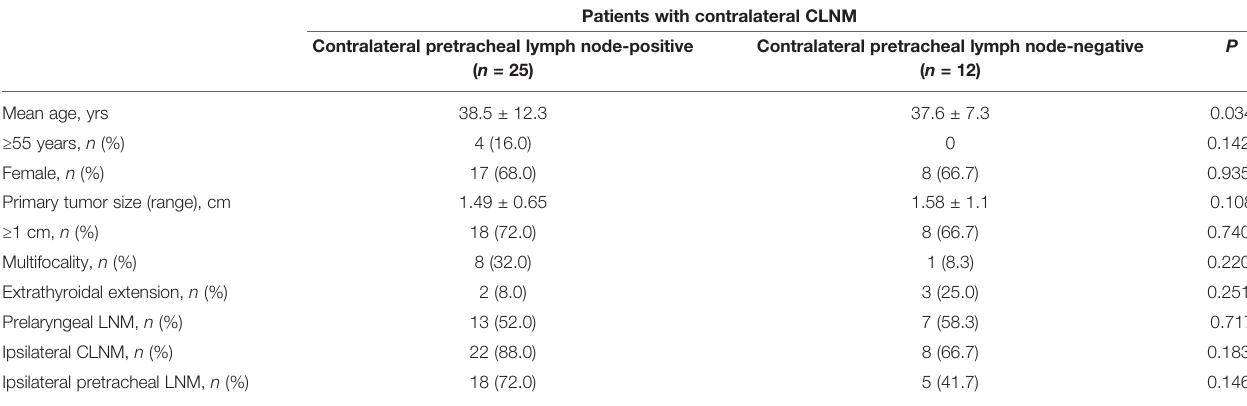
TABLE 3 | Characteristics of contralateral pretracheal lymph node positivity in patients with contralateral CLNM.